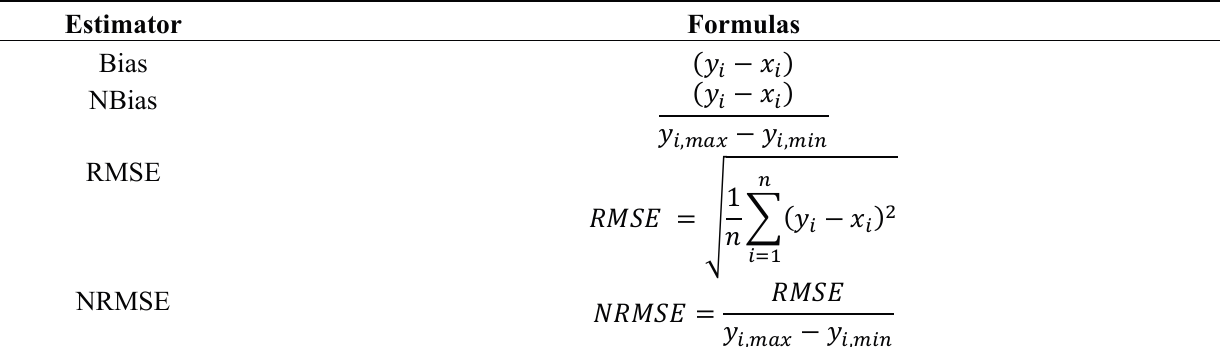
Table 2. Error estimators used in this study. NBias, normalized bias.